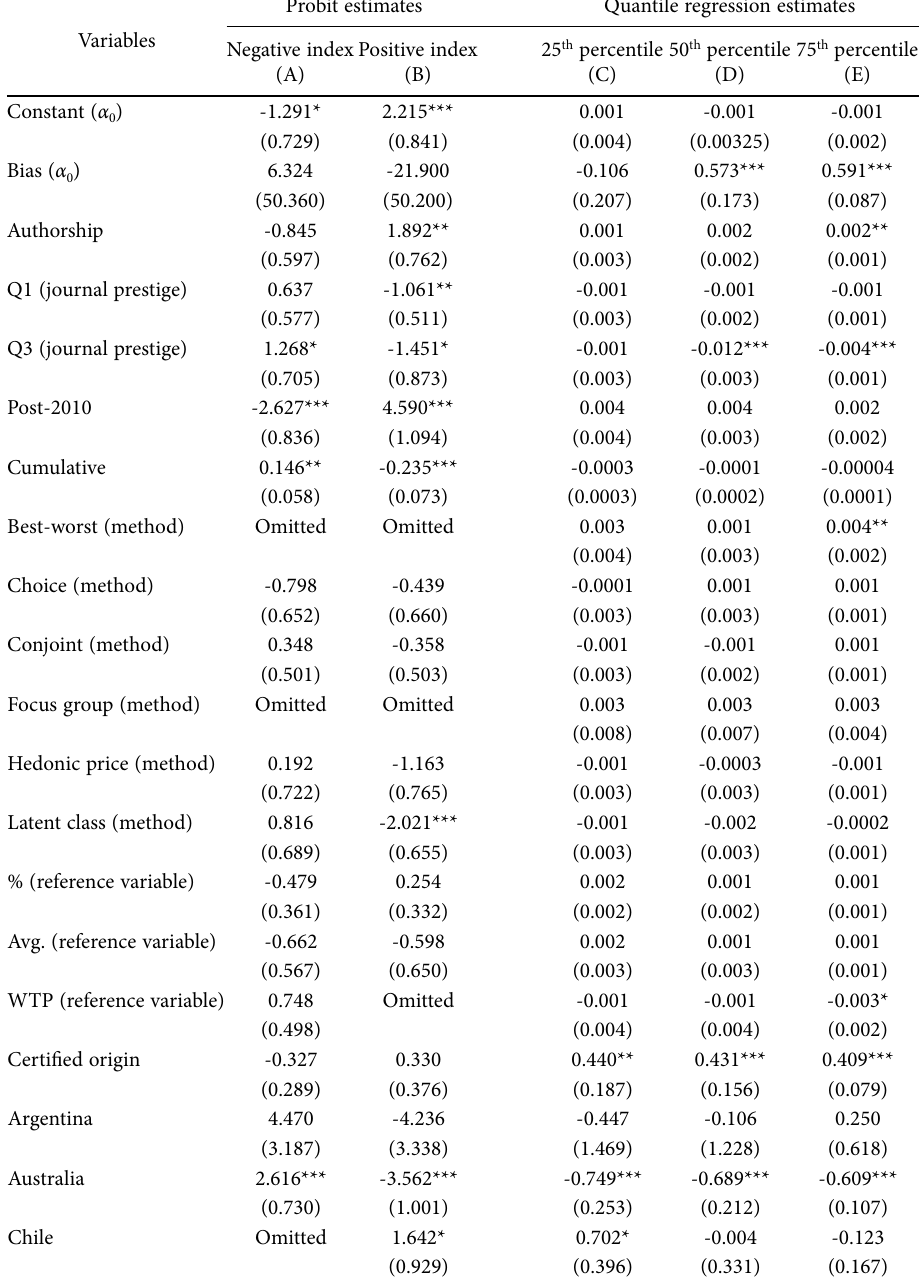
Table 4. Probit model estimation: analysis of publication selection